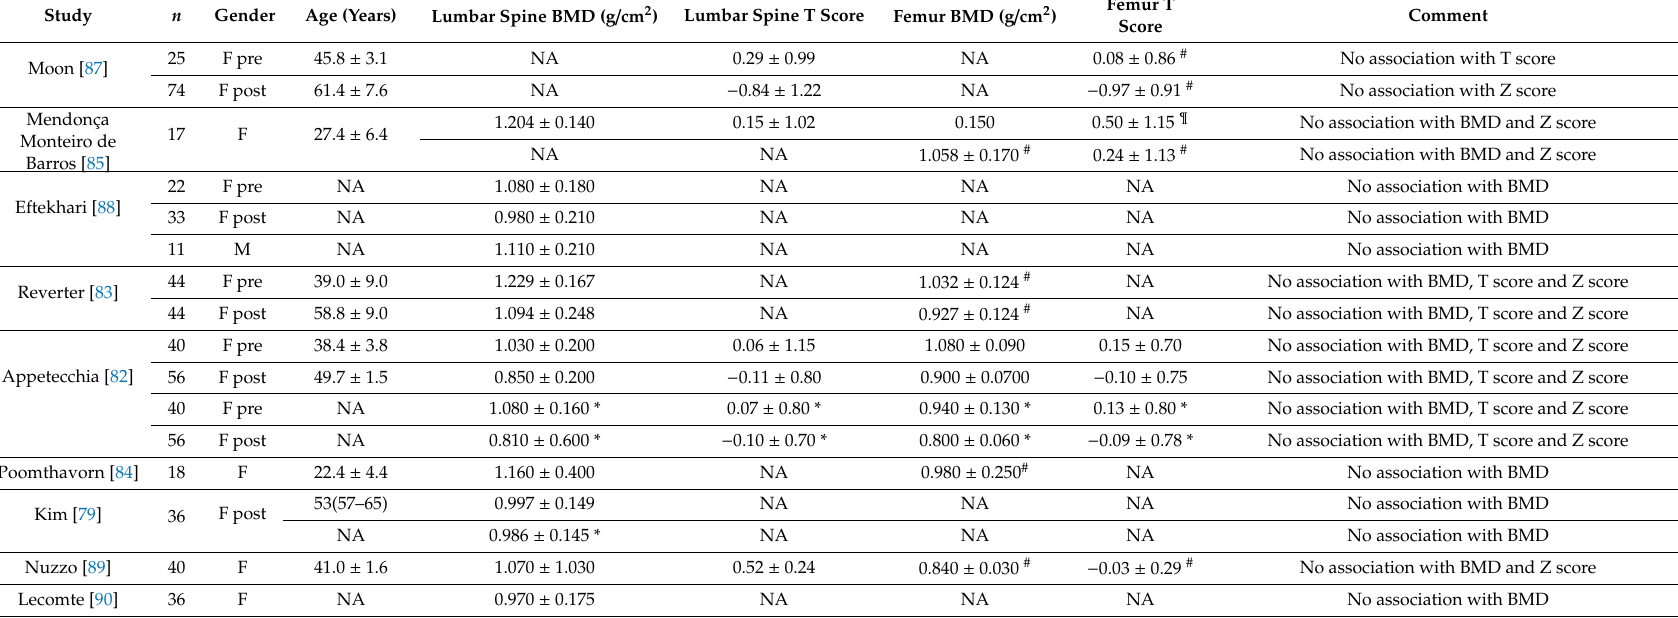
Table 3. Studies that analyzed the e ff ect of exogenous subclinical hyperthyroidism on lumbar spine bone mass density and femoral bone mass